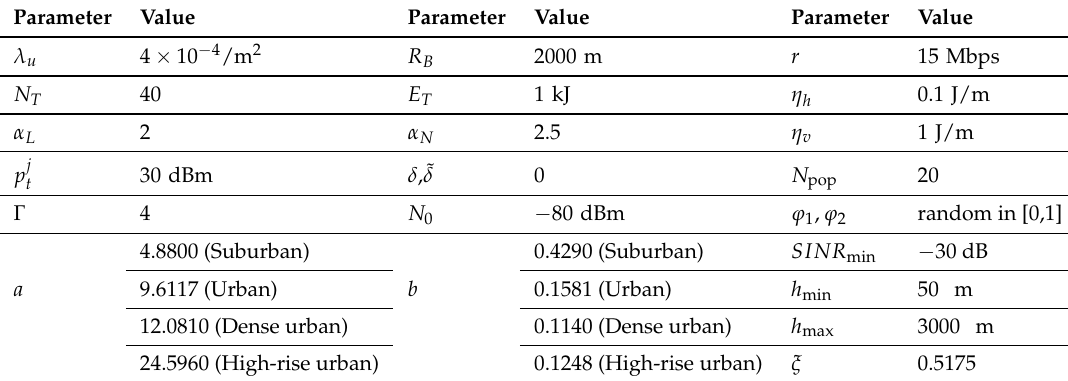
Table 2. Simulation